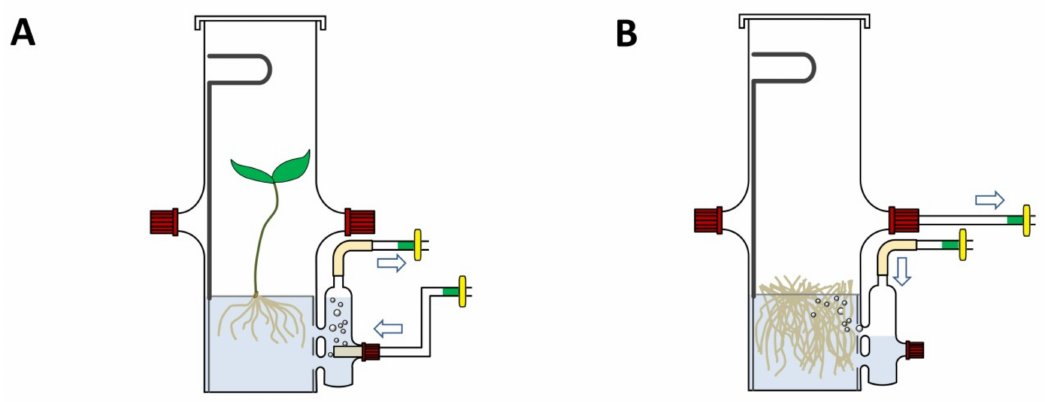
Figure 1. Scheme of bioreactor operating in airlift mode ( A ) and bubble aeration mode ( B